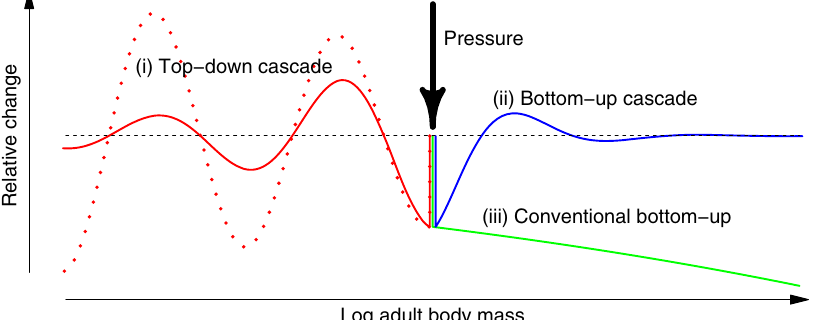
Fig. 4 The three main distinct responses of size spectra to size-speci fi c pressures. When species of a speci fi c body-size class are continuously removed from the community (thick arrow), theory predicts (i) a top-down modulation of population abundances towards smaller body-size classes, which may be either attenuating (solid red line) or amplifying (dotted red line); (ii) a bottom-up cascade in the reverse direction (blue) and (iii) an amplifying conventional bottom-up effect (green). Depending on the size class at which the pressure is applied, not all of these effects may unfold. The horizontal dashed line represents the pressure-free state. We fi nd that domes emerge when the top-down cascade becomes amplifying towards smaller body